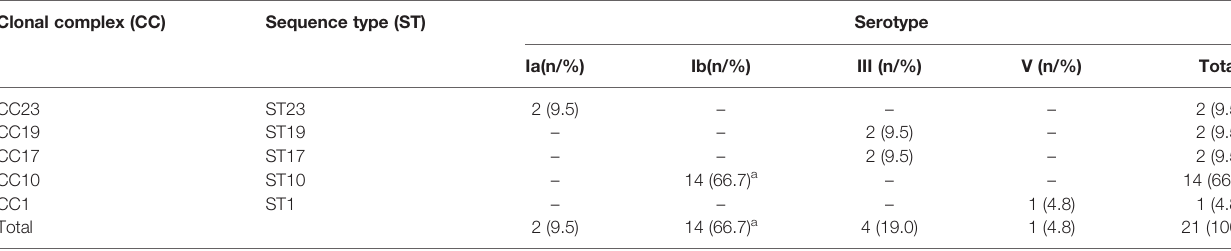
TABLE 2 | Relationships between sequence type and serotype in 21 invasive GBS isolates. Clonal complex